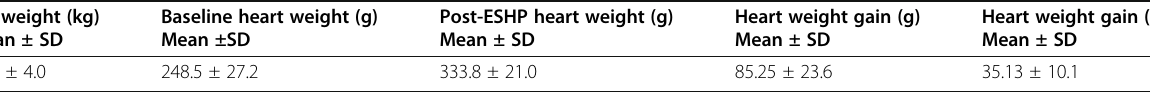
Table 2 Macroscopic evaluation of the donor heart over the course of the experiment Pig weight (kg) Mean ±